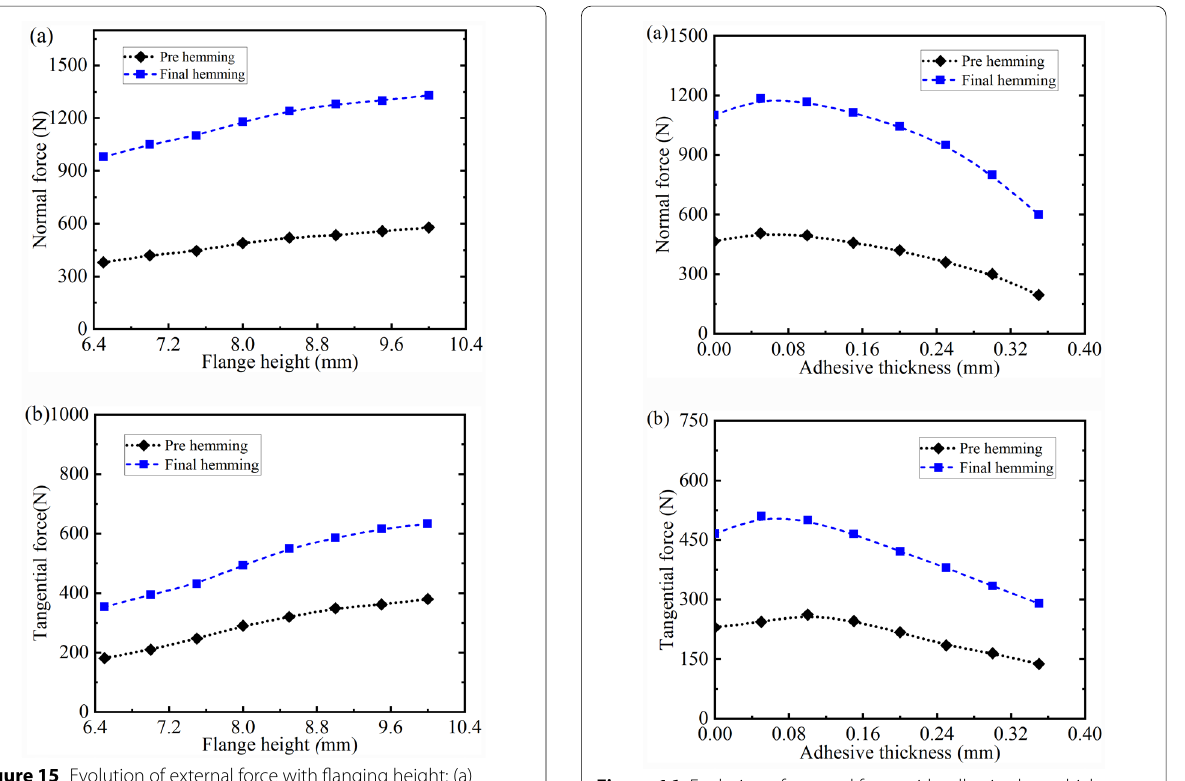
Figure 16 Evolution of external force with adhesive layer